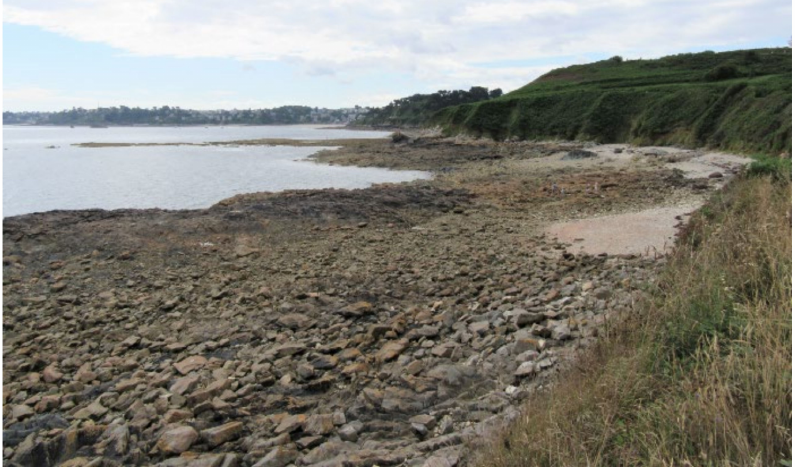
Figure 1. The study area along the coast, between the cities of Ploumanac’h and Perros-Guirec, at intermediate-low tide (view towards the